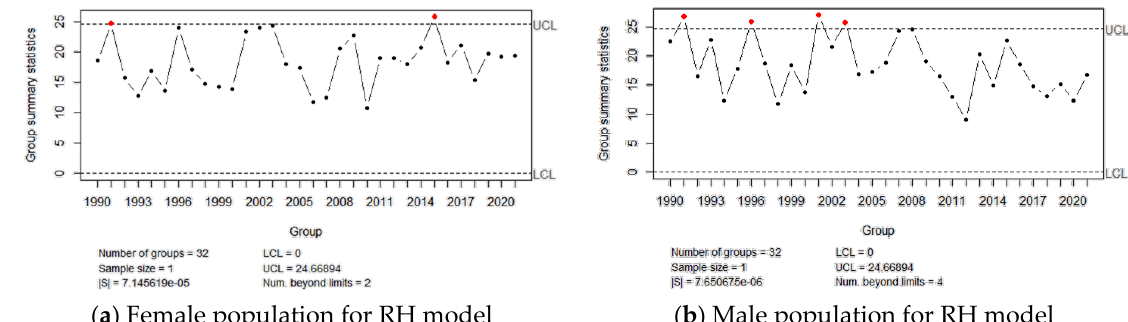
Figure 7. Hotelling T 2 control charts.